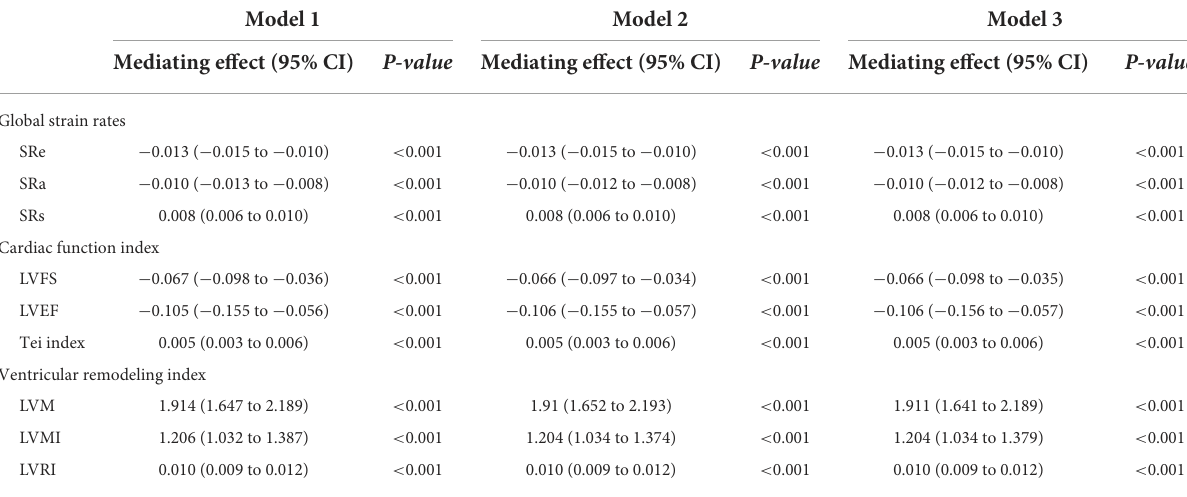
TABLE 5 The mediating effect of hsCRP in the association between salt intake and myocardial strain rates and left ventricular structure and